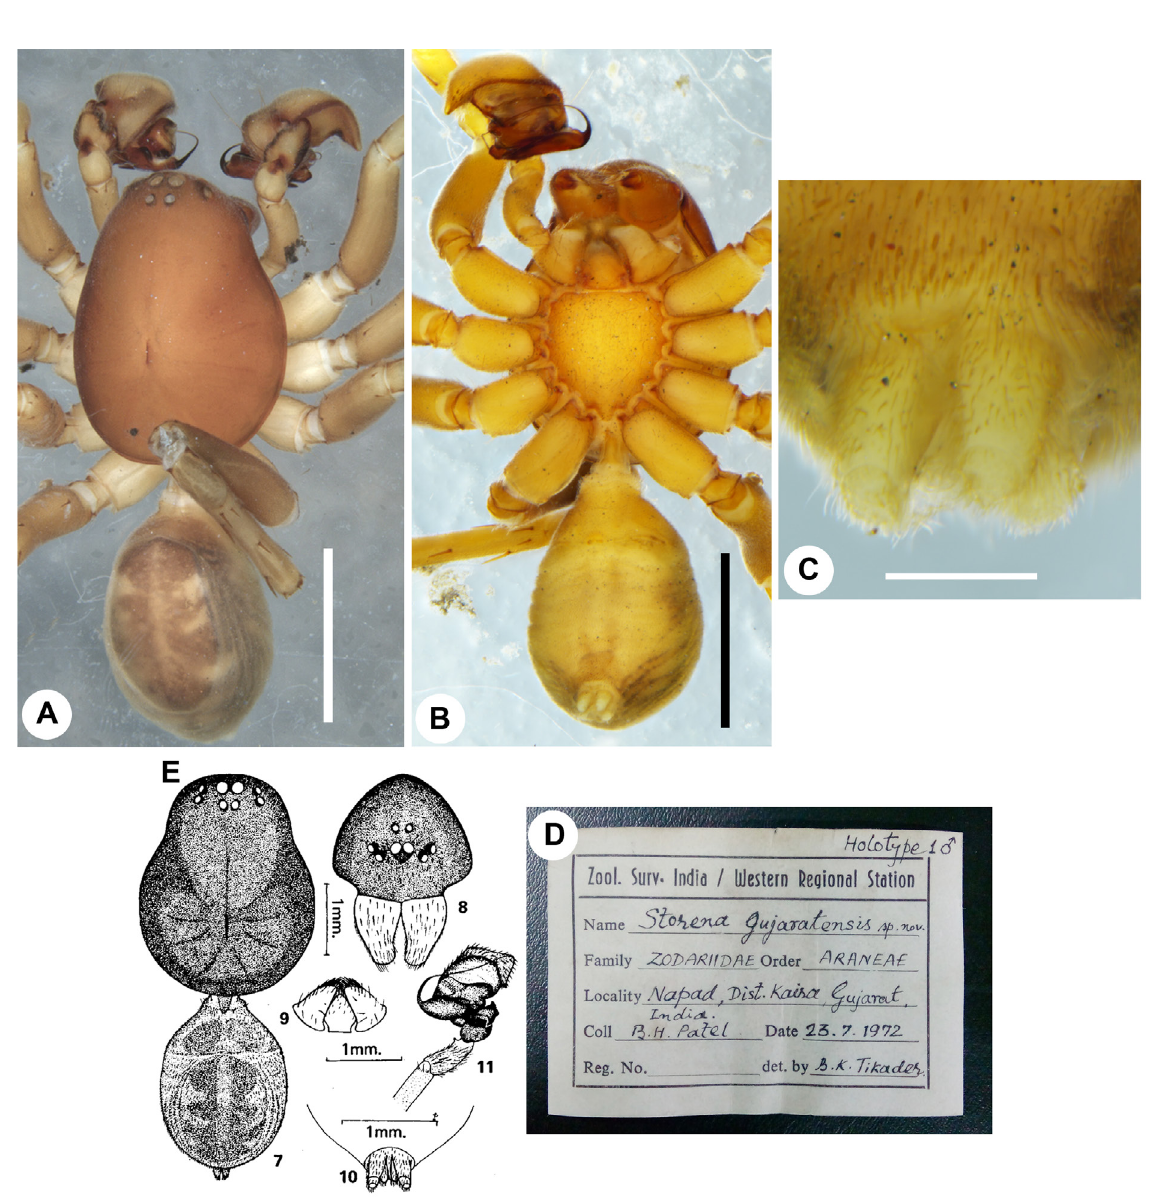
Fig. 7. Laminion gujaratensis (Tikader & Patel, 1975) gen. et comb. nov., ♂, holotype of Storena gujaratensis Tikader & Patel, 1975. A . Male habitus, dorsal view. B . Same, ventral view. C . Spinnerets showing PVS, ventral view. D . Type label. E . Original illustrations of S. gujaratensis adapted from Tikader & Patel (1975). Scale bars: A–B = 2 mm; C = 0.1